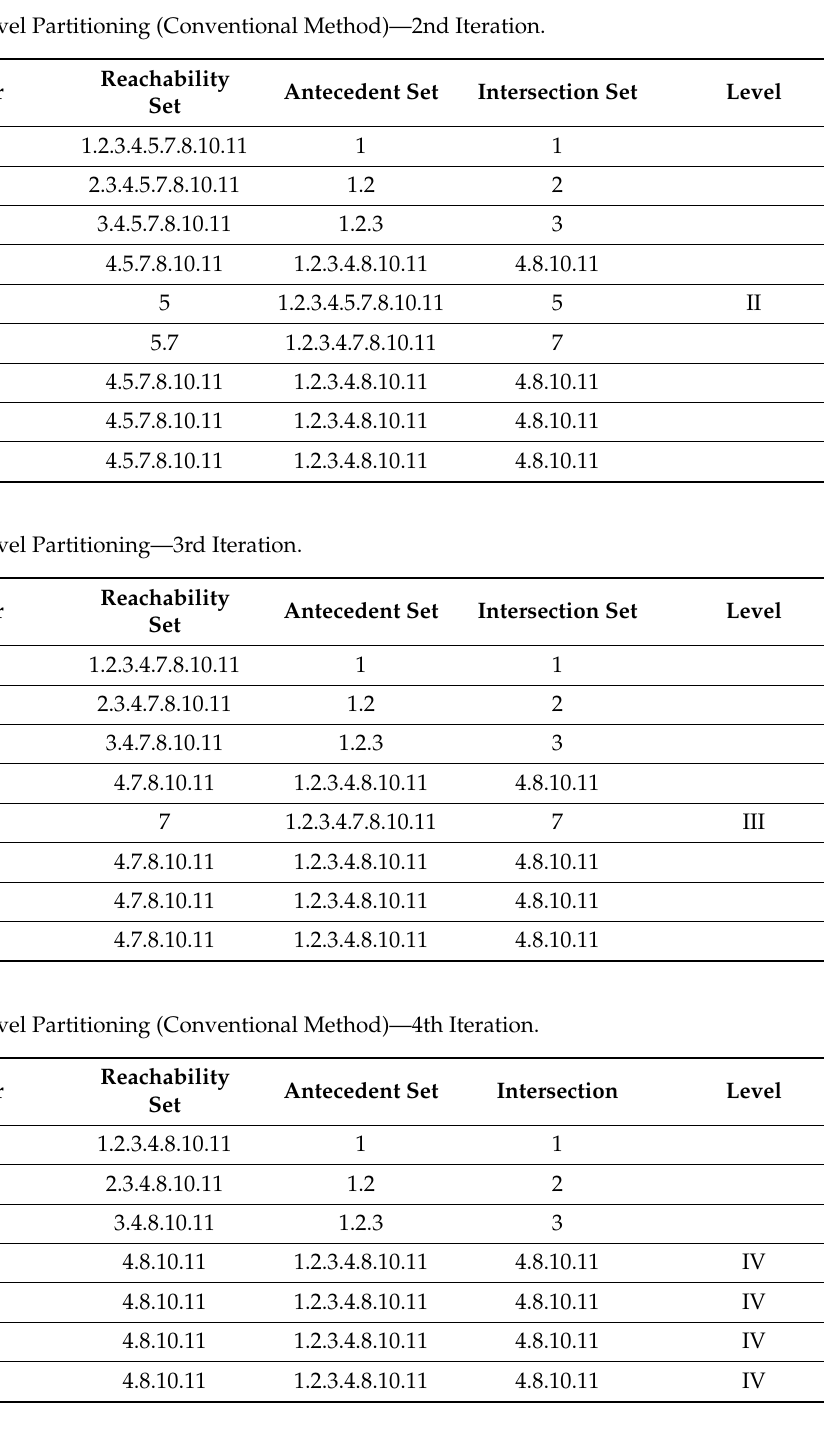
Table A8. Level Partitioning (Conventional Method)—5th and 6th